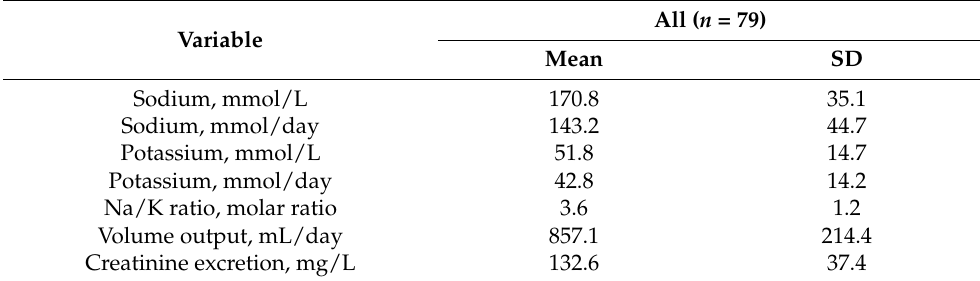
Table 2. Urinary data on sodium and potassium